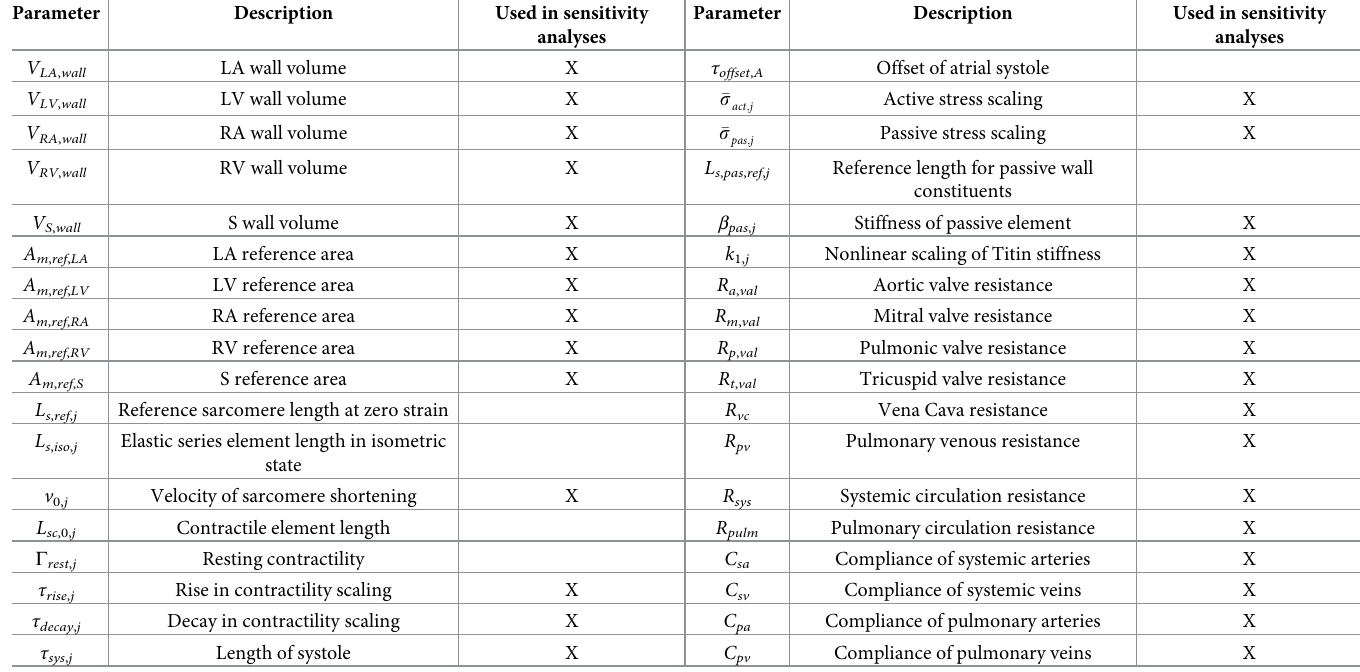
Table 1. Parameters, their description, and information regarding the sensitivity analyses. Parameters with the subscript j have atrial and ventricular